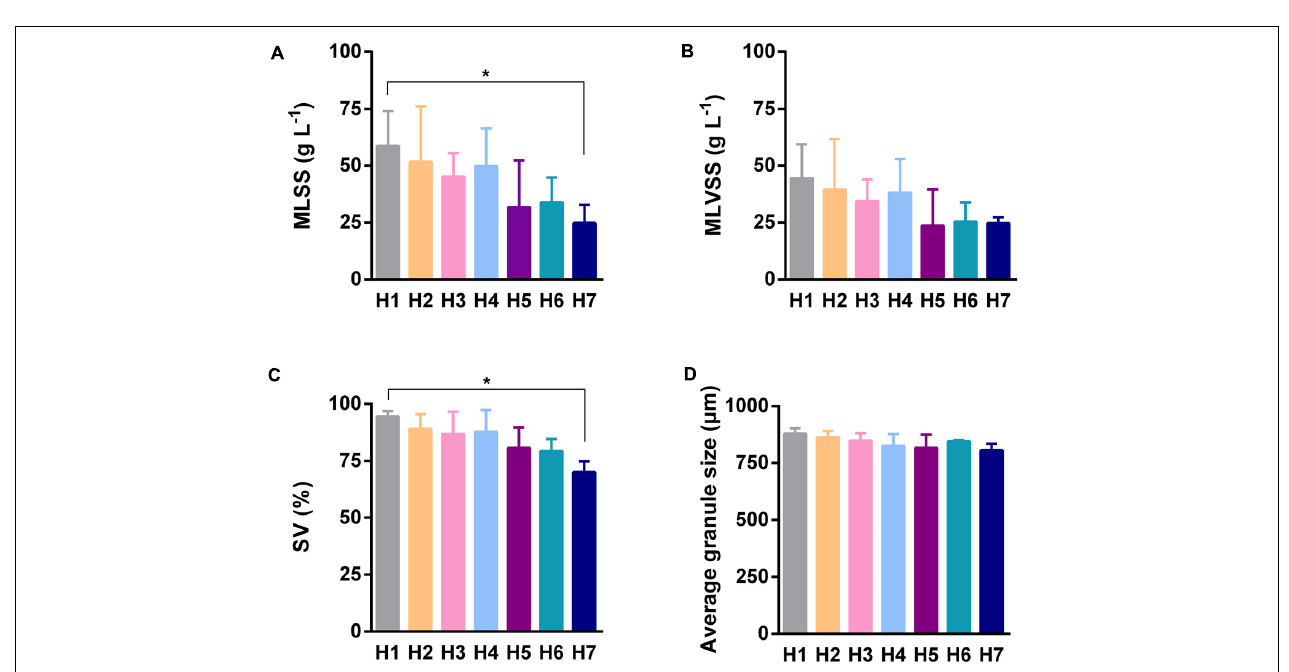
FIGURE 3 | Characteristics of AGS of different sampling heights. (A) The mixed liquid suspended solids of sludge. (B) The mixed liquor volatile suspended solids of sludge (biomass). (C) The percentage of sludge volume. (D) The average diameter of granule. Error bar was SD obtained based on the five times sampling data, ANOVA of Kruskal–Wallis test was used to analyze variation between different sampling heights, ∗ P < 0.05.